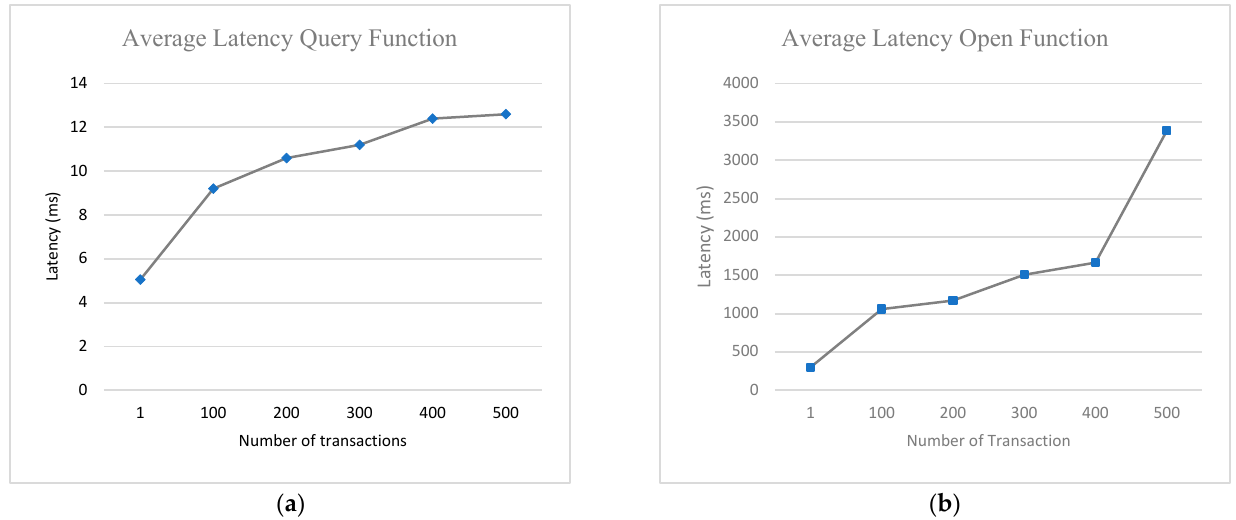
Figure 10. System average latency for ( a ) Query function ( b ) Open function with varying number of transactions.